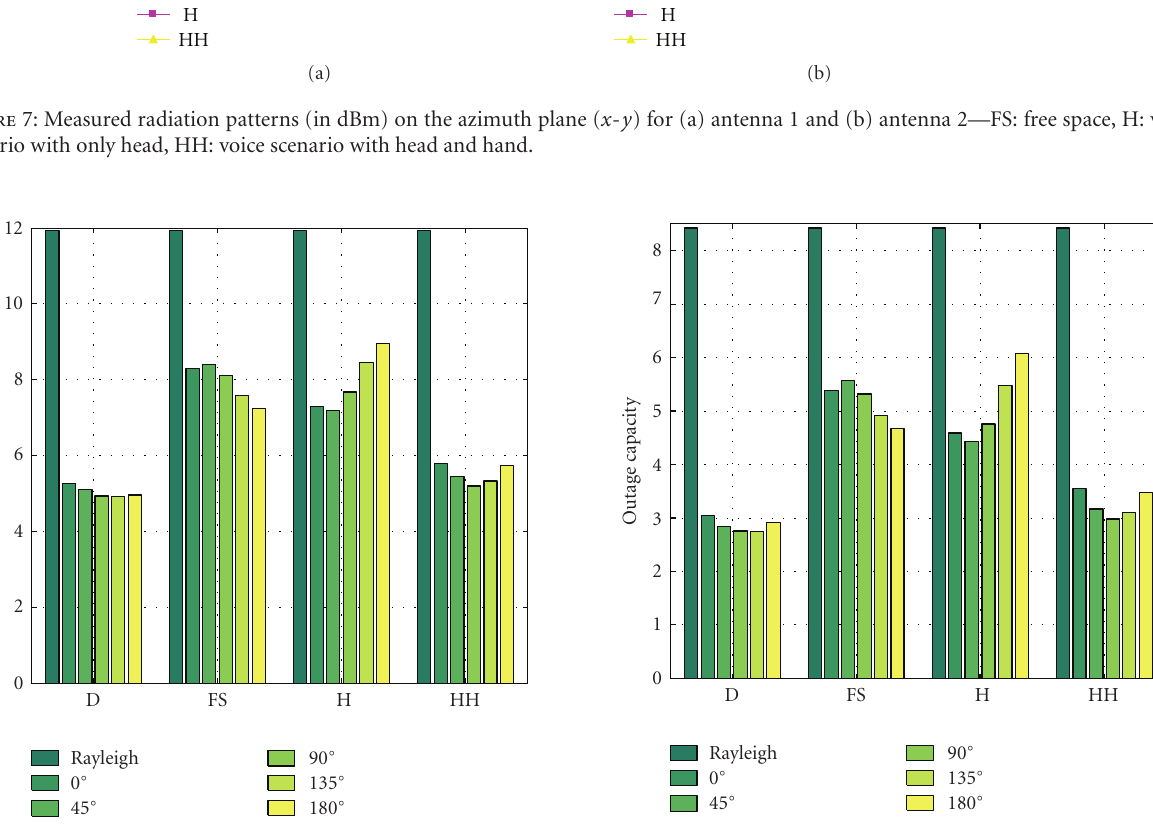
Figure 9: Outage channel capacity in the di ff erent usage scenarios at di ff erent user